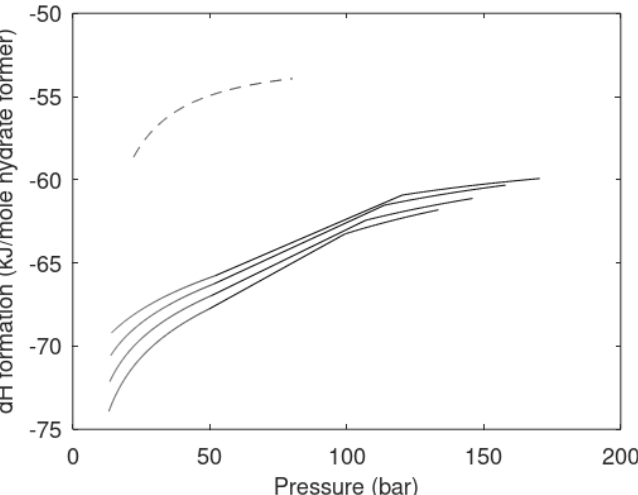
Figure 7. Enthalpies of hydrate formation in kJ/mol hydrate former as function of pressure. The bottom solid curve corresponds to CO 2 /CH 4 mixture with 10 mol % CH 4 ; the top solid curve is pure CO 2 ; 5 mol % CH 4 and 2 mol % CH 4 curves fall in between. The dashed curve is the corresponding results for pure CH 4 hydrate.